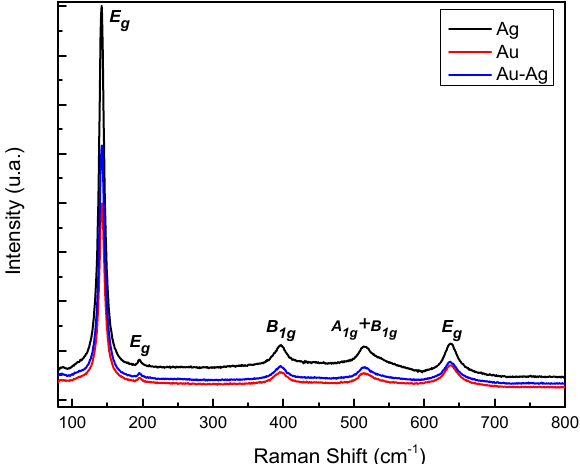
Figure 4. Raman spectra of TiO 2 Au, Ag, and Au-Ag modified thin films. Figure 5 shows the vibrational mode corresponding to 517.4 cm − 1 (A 1g + B 1g ). It presents a clear broadening of the signal between 520 and 560 cm − 1 ; previous studies attributed the presence of this signal (Figure 5b,c) to the presence of metallic gold on the surface of the thin film [21,41]. In the case of the film with silver, the signal broadening was lower than the corresponding signal of the films with Au (Figure 5a).